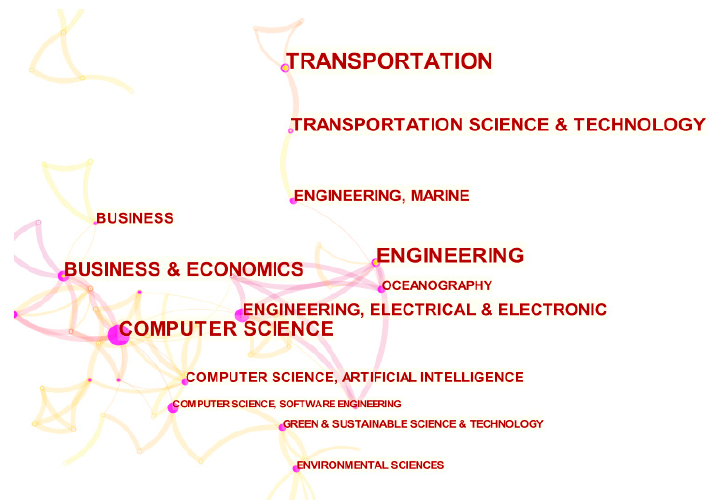
Figure 5. Categories based on the publications.